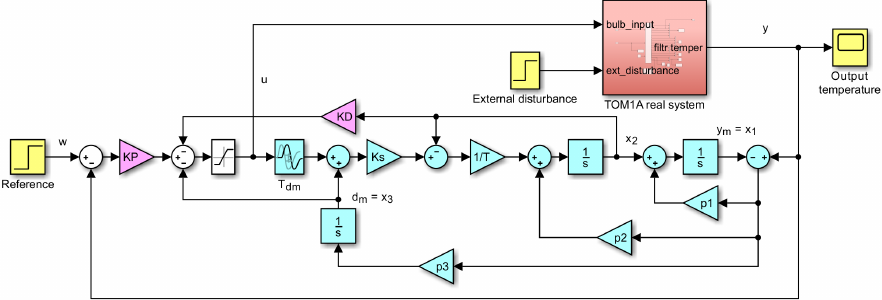
Figure 3. ADRC 2 ( T d ) (modified ESO blocks with blue background) -controller scheme corresponding to the model S 2 ( s ) , T = T 1 , T d = T dm , y = y m , d = d m